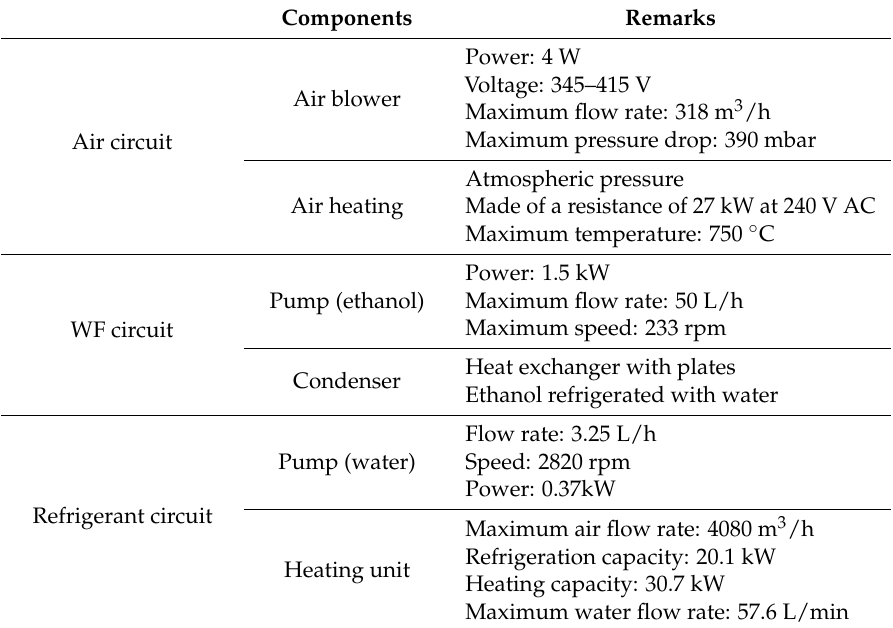
Table 1. Main components of the test bench. WF—working fluid; AC—alternating current. Components